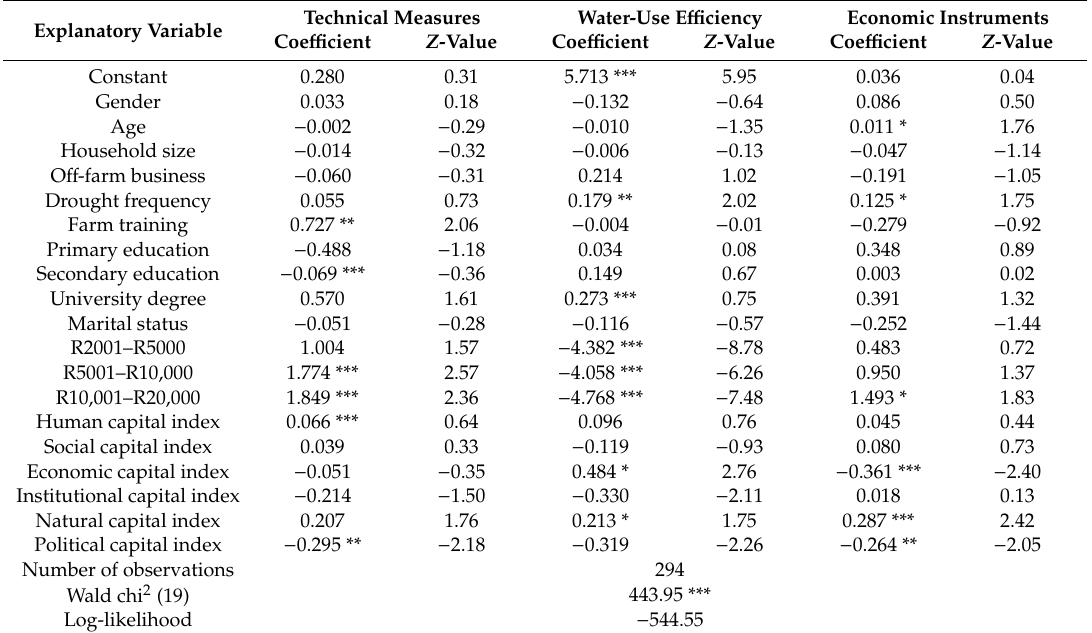
Table 4. Estimates of the multinomial probit model on the choices of e ff ective adaptation strategies.